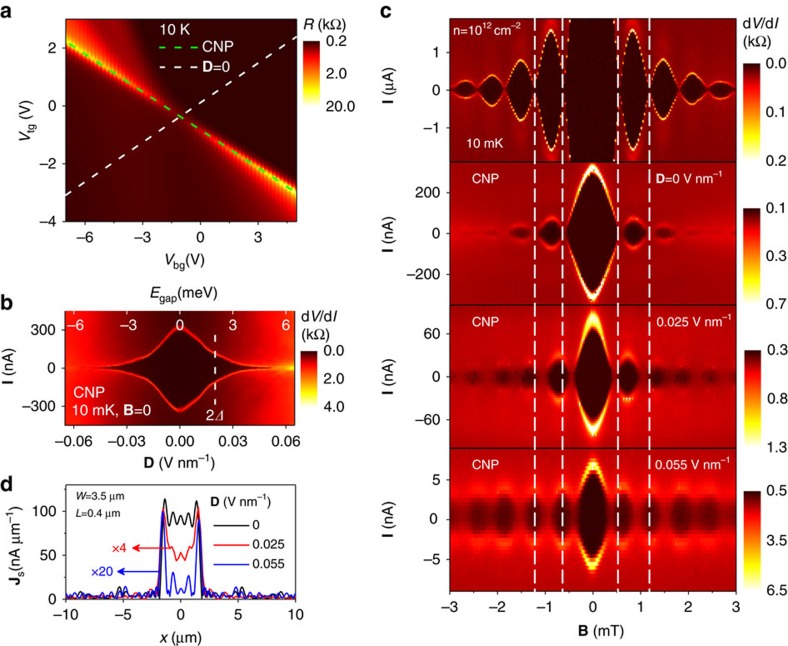
Redistribution of supercurrent as the gap opens in bilayer graphene.(a) Resistance R of one of our Josephson junctions (3.5 μm wide and 0.4 μm long) above the critical T as a function of top and bottom gate voltages. The dashed white line indicates equal doping of the two graphene layers with carriers of the same sign. The dashed green line marks the CNP (maximum R) and indicates equal doping with opposite sign carriers. (b) Differential resistance dV/dI measured along the green line in a at low T and in zero B. Transition from the dissipationless regime to a finite voltage drop shows up as a bright curve indicating Ic. The vertical line marks the superconducting gap of our Nb films. (c) Interference patterns in small B. The top panel is for the case of high doping [Ic(B=0) ≈10 μA] and indistinguishable from the standard Fraunhofer-like behaviour illustrated in Fig. 1d. The patterns below correspond to progressively larger Egap. Changes in the phase of Fraunhofer oscillations are highlighted by the vertical dashed white lines. (d) Extracted spatial profiles of the supercurrent density (Js) at the CNP for the three values of D in c.